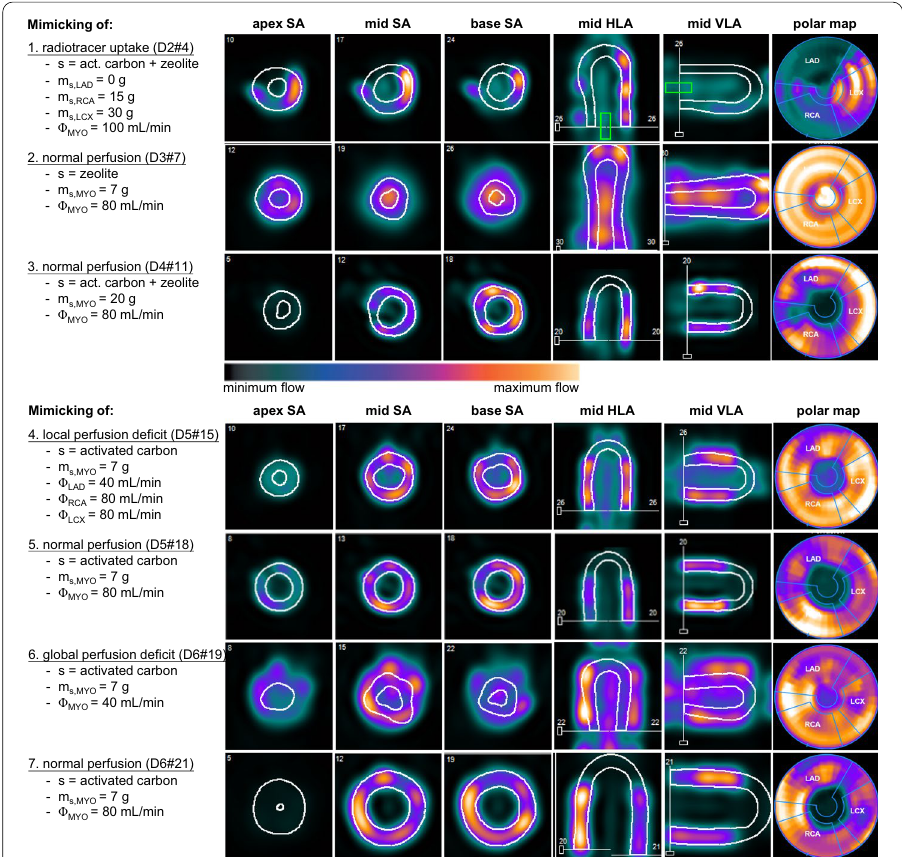
Fig. 4 A selection of seven myocardial perfusion imaging series aiming to highlight the overall phantom development and evaluation process. The image cross sections and polar maps present the accumulated radiotracer distribution inside the phantom, which is a static representation of a dynamic measurement. Note that the relative color scale is determined by default for each individual measurement and is therefore not linked between measurements. In these measurements, mimicking of radiotracer uptake, normal perfusion and perfusion deficit was examined using different parameter settings. Settings include the type and mass of sorbent ( s ) utilized to mimic myocardial tissue, and the amount of volume flux ( Φ ) directed through the myocardial segments (MYO). D2#4 stands for the measurement day and number, respectively. LAD left anterior descending coronary artery, RCA right coronary artery, LCX left circumflex coronary artery, SA short axis, HLA horizontal long axis, VLA vertical long